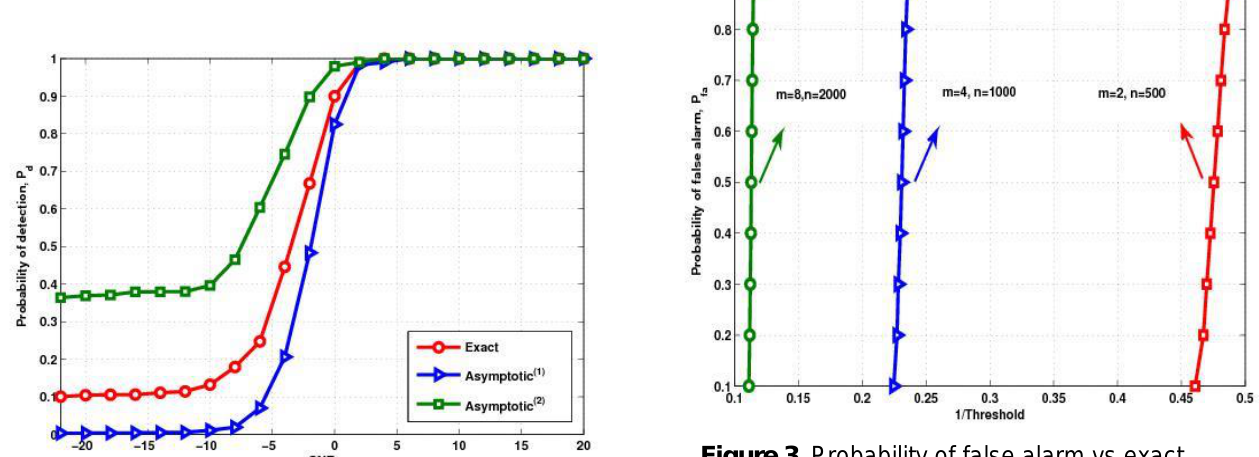
Figure 1. Probability of false alarm for MME vs exact and asymptotic thresholds for m=2 and n=20.